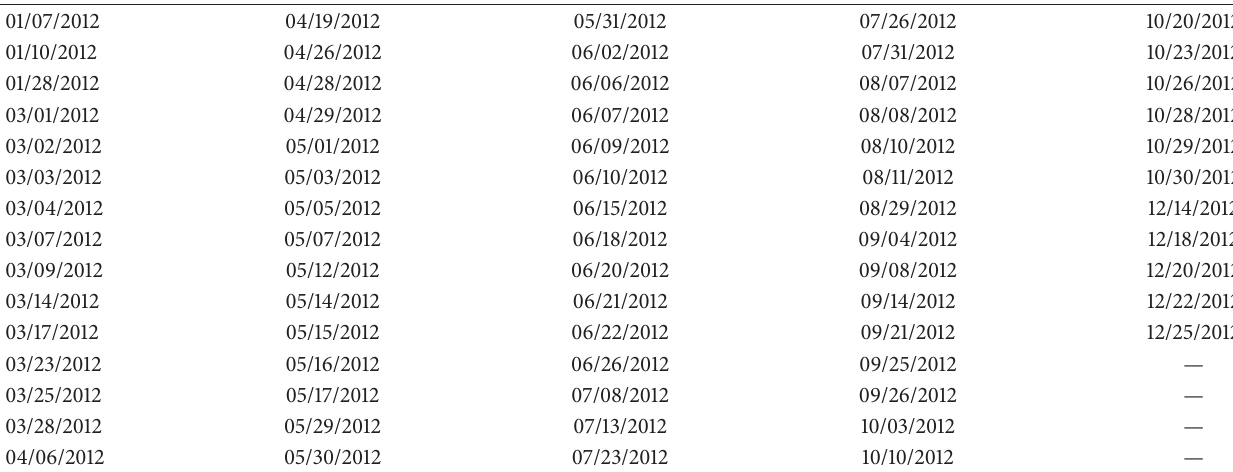
Table 1: List of all MODIS imaged days of the year of 2012 used in the SAFER analysis. All these images were selected by having clear and high quality data for the pixel regarding an area of Caatinga at Embrapa Semi´arido, which is a research station of the state of Pernambuco, Brazil (9 ∘ 05 󸀠 S; 40 ∘ 19 󸀠 W; 350